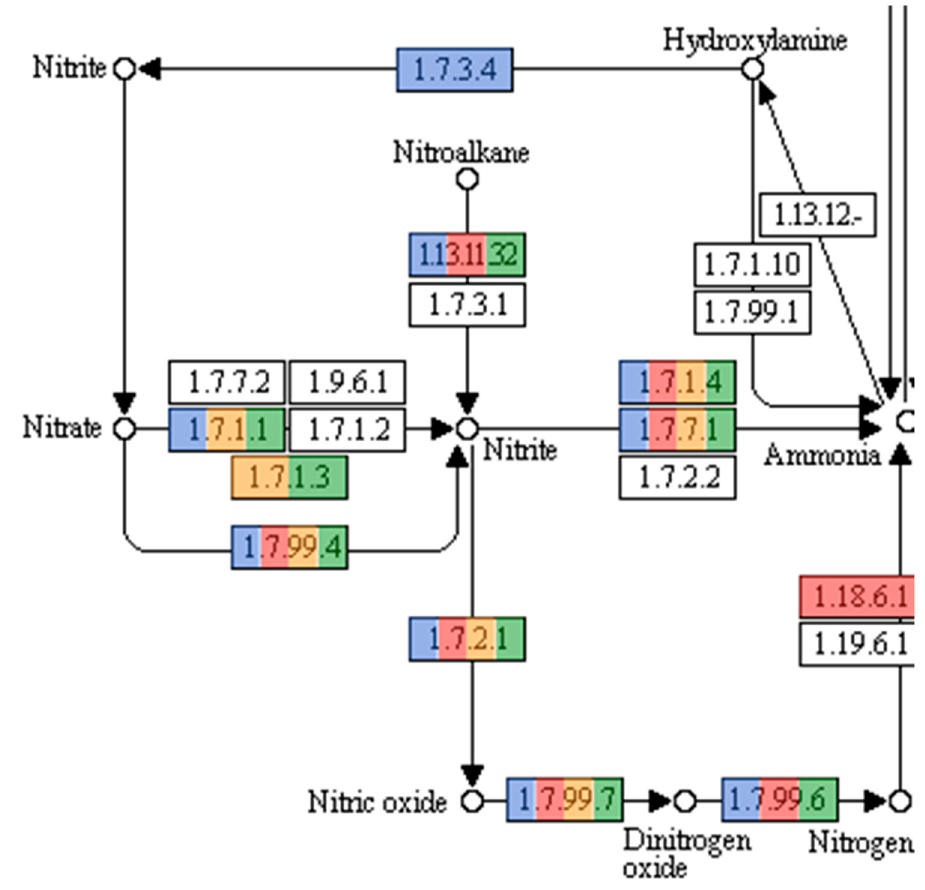
Figure 5. Nitrogen metabolism pathways present in the three metagenomes. Colored enzymes (Light blue and green for MFF1, red for MFF2, orange for MFF3) indicate the presence of hits related to the enzyme in the metagenome (number of hits for each enzyme can be seen at Table S1 of supplementary figures). Enzymes related to reductive pathways in the nitrogen cycle were encountered, including nitrate reductase (Enzyme Nomenclature database numbers (EC) 1.7.1.1, 1.7.1.3, 1.7.99.4), nitrite reductases (EC 1.7.2.1, 1.7.7.1, 1.7.1.4), and the nitrogenase needed for nitrogen fixation (EC 1.18.6.1). Pathways obtained from KEGG pathways ( https://www.genome.jp/kegg/pathway.html ) with permission.